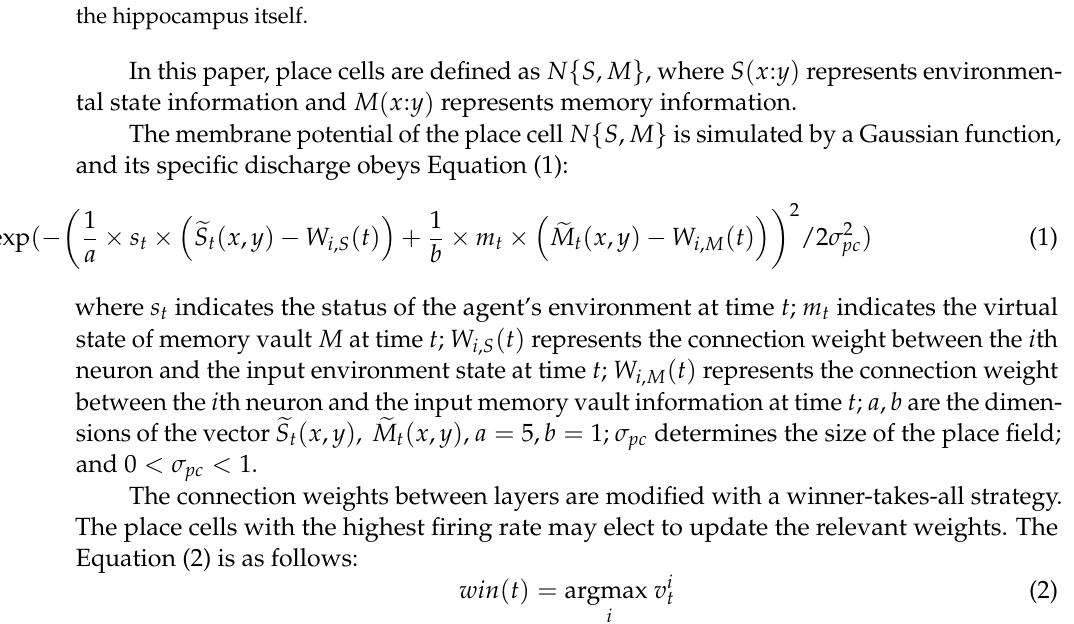
Figure 2. A schematic diagram of a place cell network. The input layer of place cells has two signal sources: One is state information from the environment, and the other is memory information from the hippocampus itself.